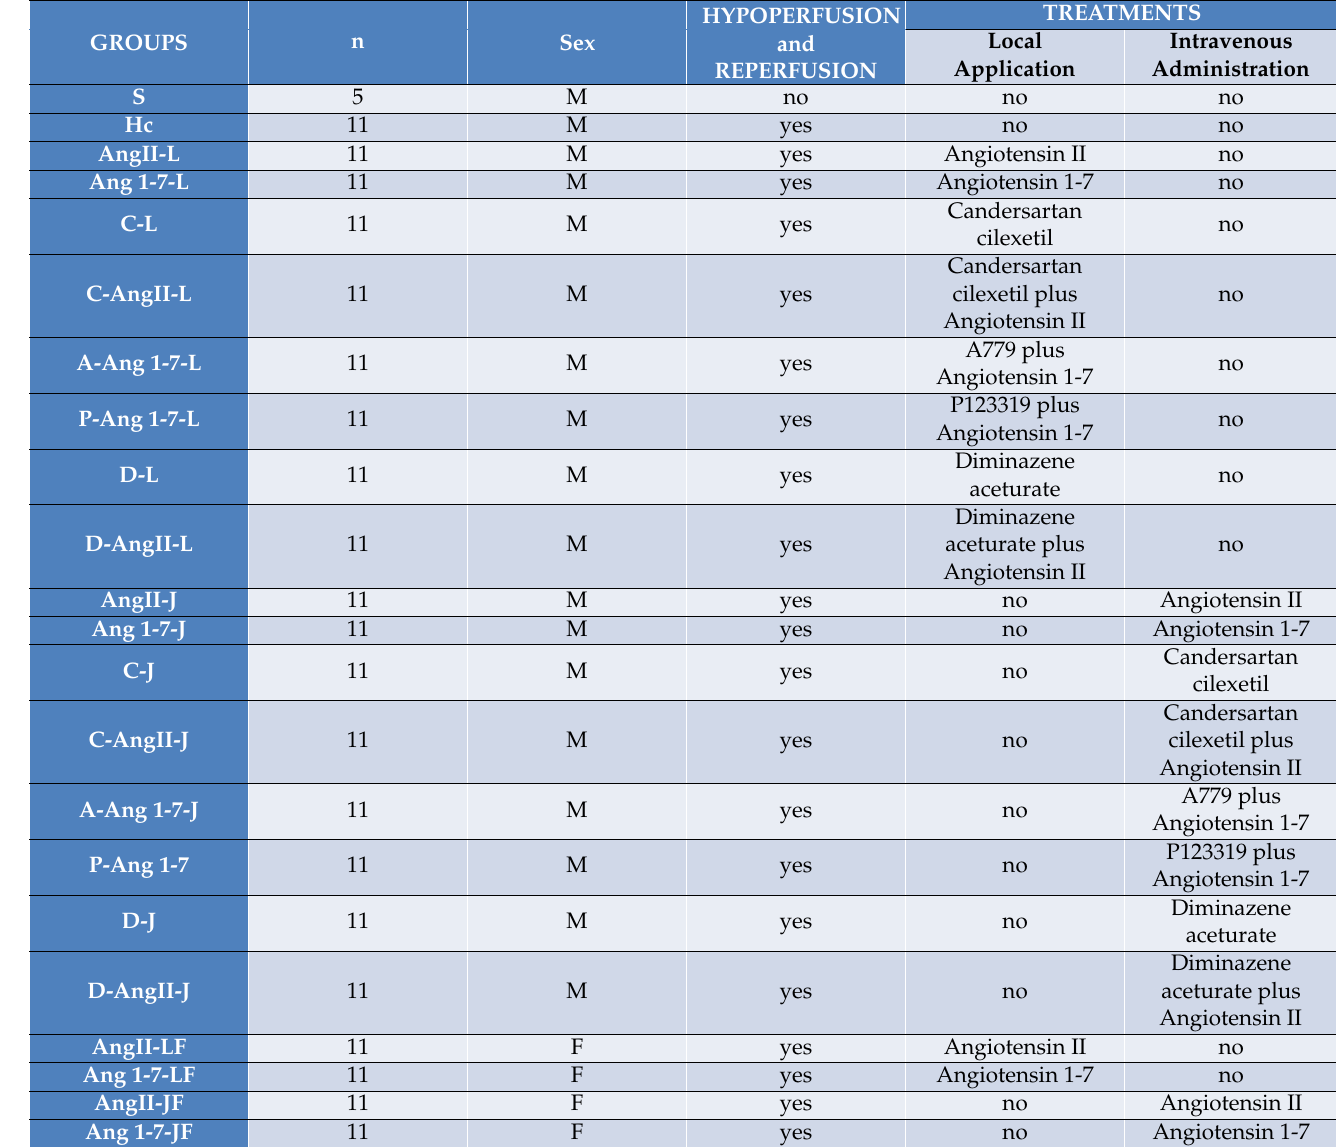
AngII:L-J indicates AngII-L group and AngII-J group. Groups 11-18, male rats subjected to BCCAO and to reperfusion, were treated with the following compounds infused in the right jugular vein 10 min before hypoperfusion and at the beginning of reperfusion: Group 11 (AngII-J group; n = 11) were administered with Ang II (10 µ g/kg); Group 12 (Ang1-7-J; n = 11) with Ang 1-7 (1 mg/kg); Group 13 (C-J; n = 11) with candesartan cilexetil (15 mg/kg); Group 14 (C-AngII-J group; n = 11) with candesartan cilexetil (15 mg/kg) plus Ang II (10 µ g/kg); Group 15 (A-Ang1-7, n = 11) with A779 (1 mg/kg) plus Ang 1-7; Group 16 (P-Ang1-7, n = 11) with PD123319 (5 mg/Kg) plus Ang 1-7; Group 17 (D-J group, n = 11) with diminazene aceturate (10 mg/kg); Group 18 (D-AngII-J group, n = 11) with diminazene aceturate (10 mg/kg) plus Ang II (10 µ g/kg). The last 4 groups comprised female rats subjected to BCCAO and to reperfusion and treated: Group 19; AngII-LF group, n = 11, with local application on pial surface of AngII at 5 × 10 − 9 M; (Group 20; Ang1-7-LF group; n = 11) or of Ang 1-7 at 10 − 9 M. Group 21 rats, AngII-JF group; n = 11, were administered AngII at 10 µ g/kg or Ang 1-7 at 1 mg/kg in the right jugular vein (Group 22; Ang1-7-JF, n =